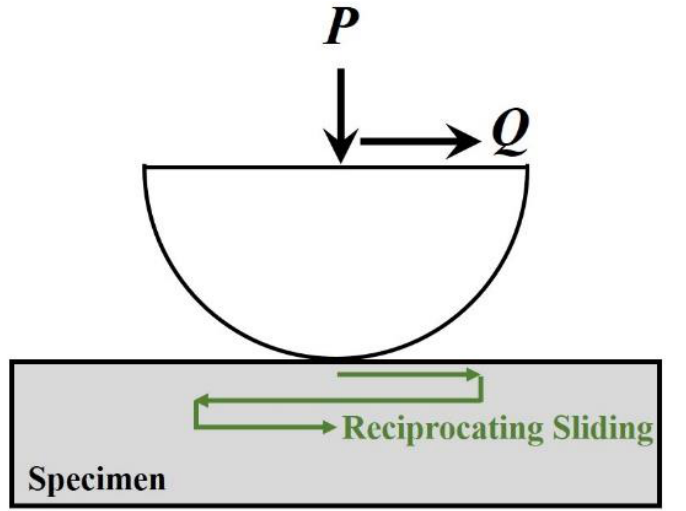
Figure 11. Schematic diagram of fretting experiment.